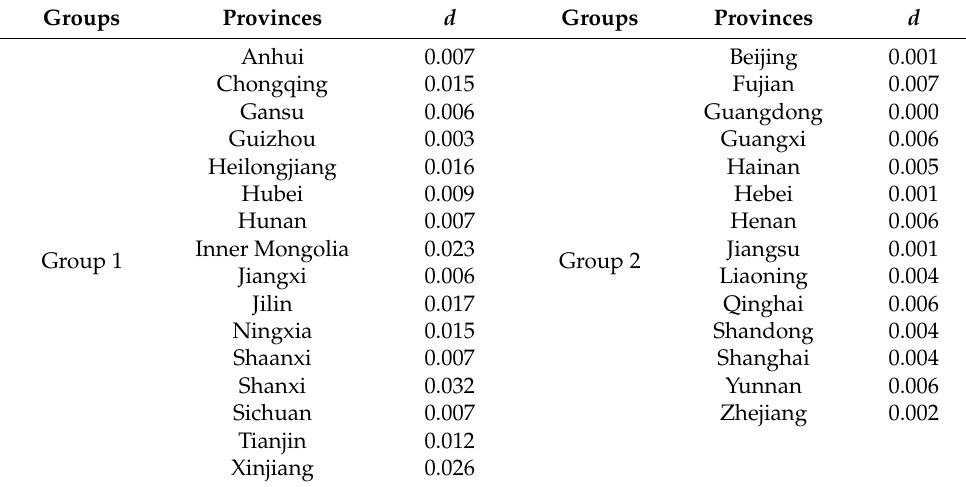
Table 6. Results of Durbin Watson